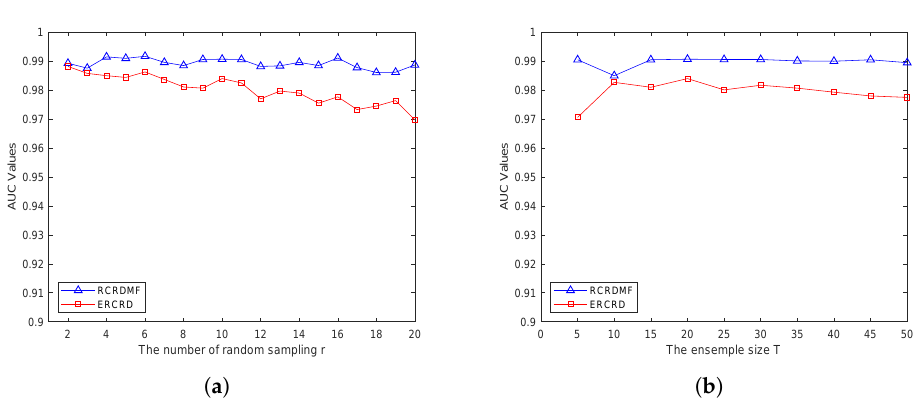
Figure 17. Parameter effect of ( a )the number of random sampling r and ( b ) the ensemble size T on the AVIRIS-I dataset.